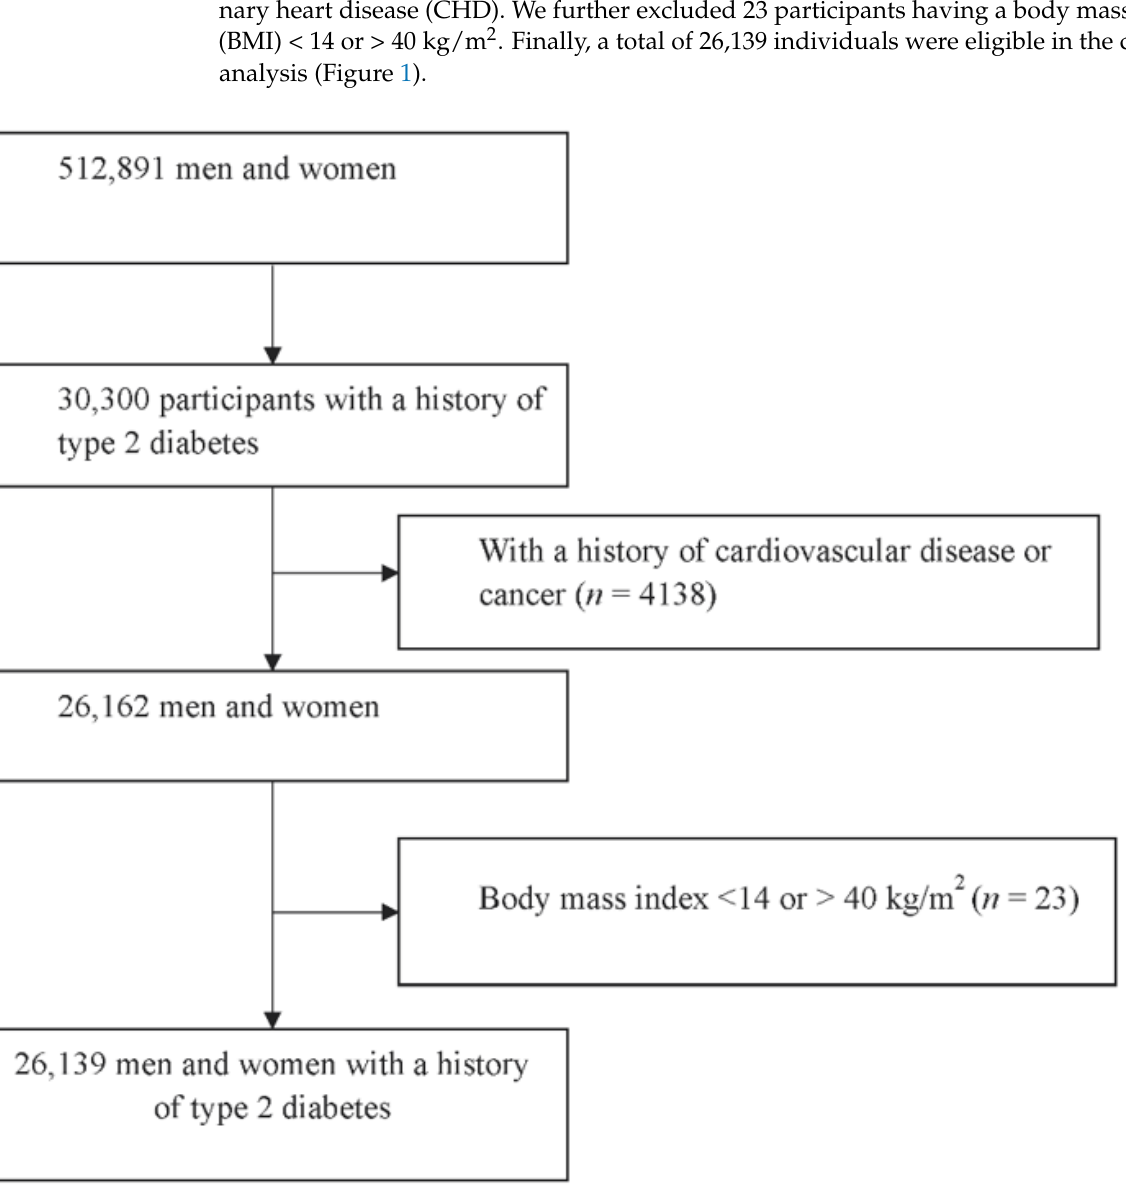
Figure 1. Flow chart of participant selection.